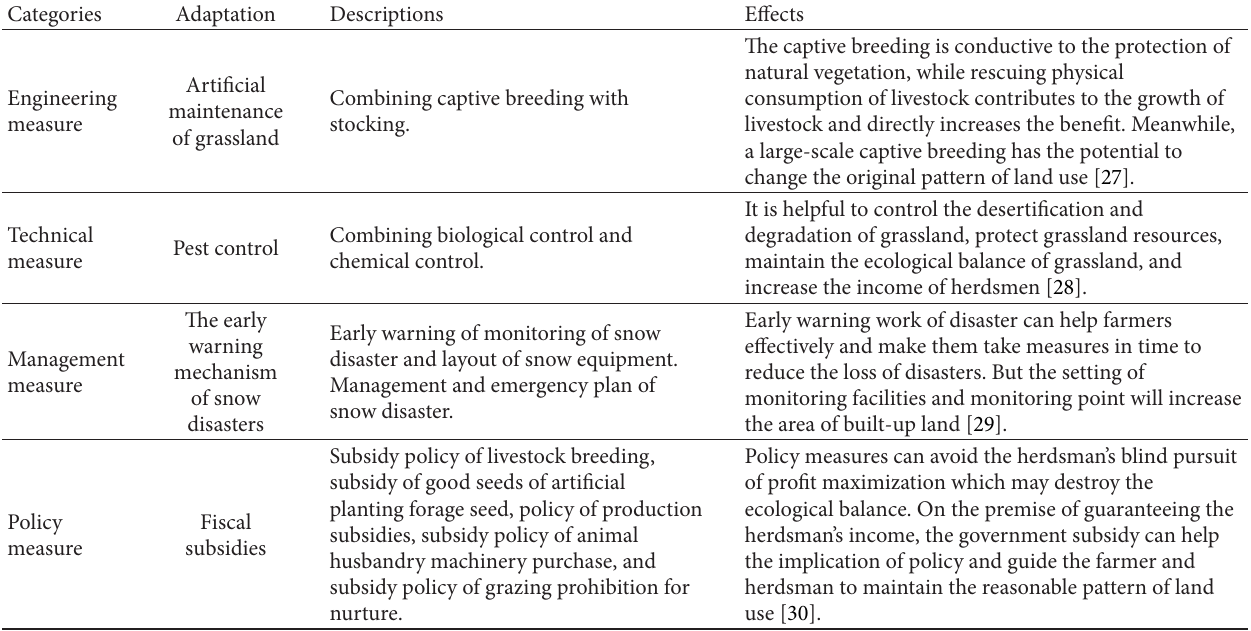
Table 1: Descriptions of various adaptation to climate